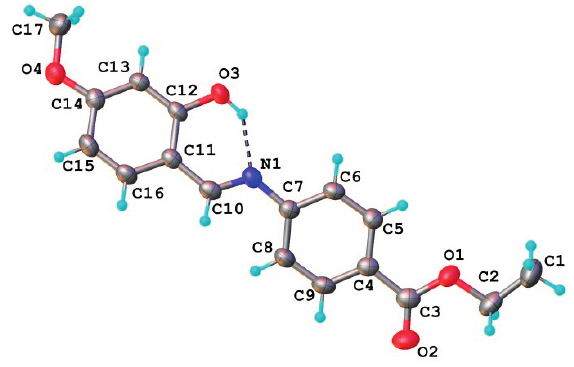
Figure 3. X-ray molecular structure of ( HL ). Thermal ellipsoids are drawn at 50% probability level. H-bond parameters: O3 − H ··· N1 [O3 − H 0.86 Å, H ··· N1 1.87 Å, O3 ··· N1 2.602(2) Å, O3 − H ··· N1